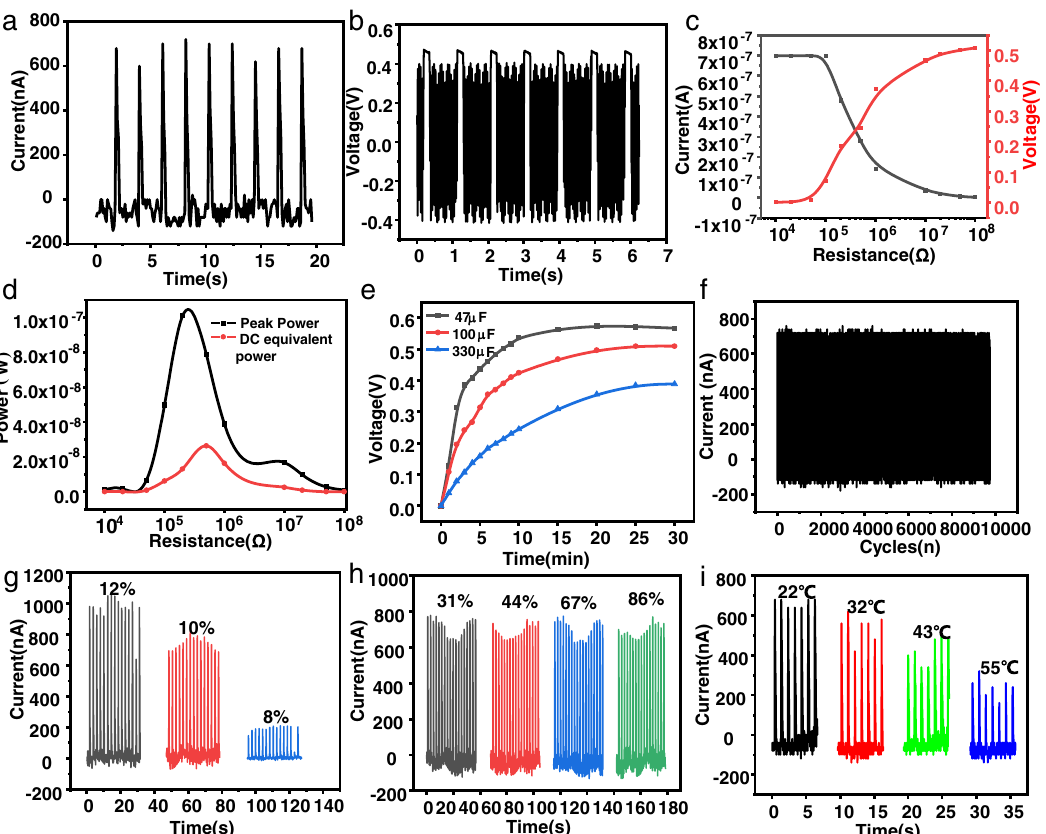
Fig. 4 | Output performance of the L-L TENG. a Closed-circuit current of the L-L TENG. b Open-circuitvoltageoftheL-LTENG. c Theelectricoutputvariationofthe L-LTENGwithaloadchange. d TherelationshipbetweenthepoweroftheL-LTENG and the load resistance. e The charging curves of commercial capacitors of 47 μ F, 100 μ F, and 330 μ F using the L-L TENG. f Repetitive cycle test results for the L-L